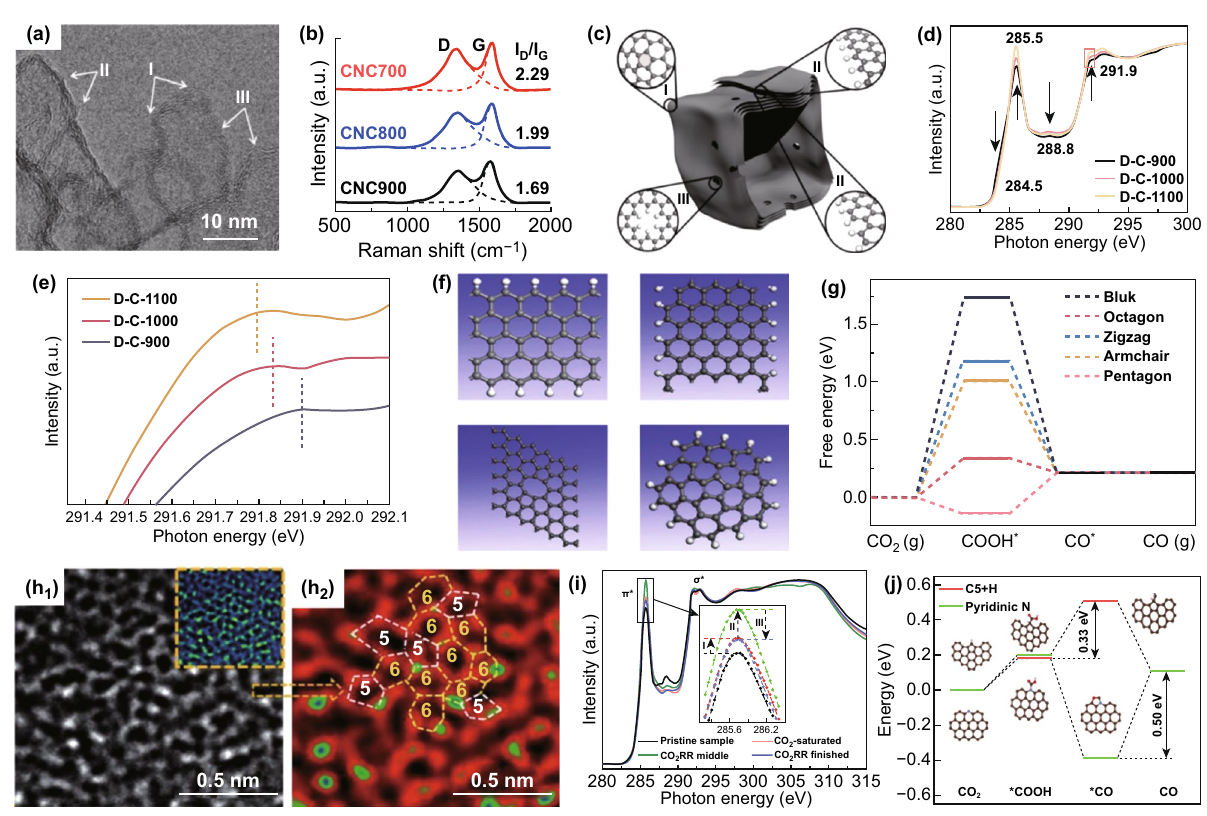
Fig. 3 Intrinsic carbon defects. a HRTEM image of CNC700. b Raman spectra. c Schematic structure characters of the carbon nanocages [91]. Copyright © 2015, American Chemical Society. C K-edge NEXAFS spectra d and e expanded view for D-C-X. f Defect models used for theo- retical calculations, g DFT calculations for ECR activities of different defects [92]. Copyright © 2019, John Wiley & Sons, Inc. Magnification of one segment of the HRTEM image h1 and h2 after fast Fourier transformation (FFT) filtering. i K-edge XAS curves of DHPC with different treatment modes. j Free energy diagram for CO2 reduction to CO over different defect sites [93]. Copyright © 2020, the Royal Society of